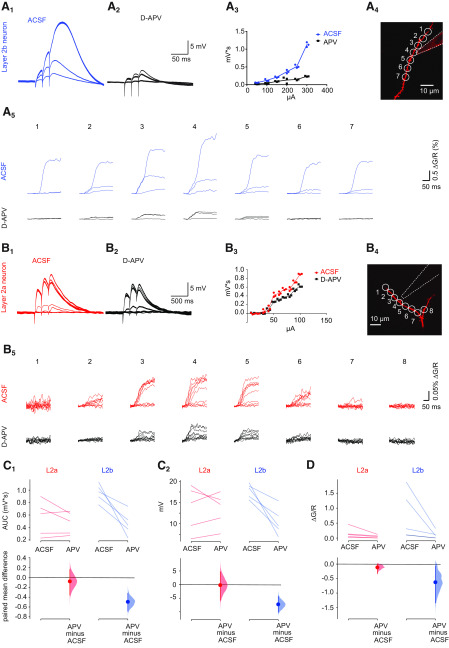
Dendritic NMDA-spikes can only be observed in layer 2b neurons. Representative layer 2b neuron (A) and representative layer 2a neuron (B). A1, B1, Overlay of electric responses measured at the soma on electrical stimulation with linear strength increase in layer 1a. A2, B2, Response to same stimulus after application of APV. A3, B3, Plot of stimulation strength against AUC from the same cell. A4, B4, Imaged dendritic branch and position of the stimulation electrode. A5, B5, Fluorescence traces of Ca2+ responses at ROIs outlined in A4/B4 under baseline conditions (upper rows, blue and red) and after application of APV (lower rows, black). Increasing stimulation strengths are overlaid. C, D, Cell-type-specific changes to NMDAR-block with APV are plotted as Cumming estimation plots. The raw data are plotted on the upper axes, each pair is connected by a line; each mean difference is plotted on the lower axes as a bootstrap sampling distribution. Mean differences are depicted as dots and the 95% confidence intervals are indicated by the ends of the vertical error bars. Red dots represent layer 2a neurons (L2a), blue dots represent layer 2b neurons (L2b). C1, AUC before and after application of APV in layer 2a neurons (L2a, red) and layer 2b neurons (L2b, blue). C2, EPSP amplitude before and after application of APV in layer 2a neurons (red) and layer 2b neurons (blue). D, Fluorescent Ca2+ response before and after application of APV in layer 2a neurons (red) and layer 2b neurons (blue). Please note that we measured Ca2+ responses in five layer 2b neurons; however, the datapoints of two measurements were very close and occlude each other. See Extended Data Table 1-2 for statistical details.Figure Contributions: Hung Lo performed the experiments and analyzed the data.